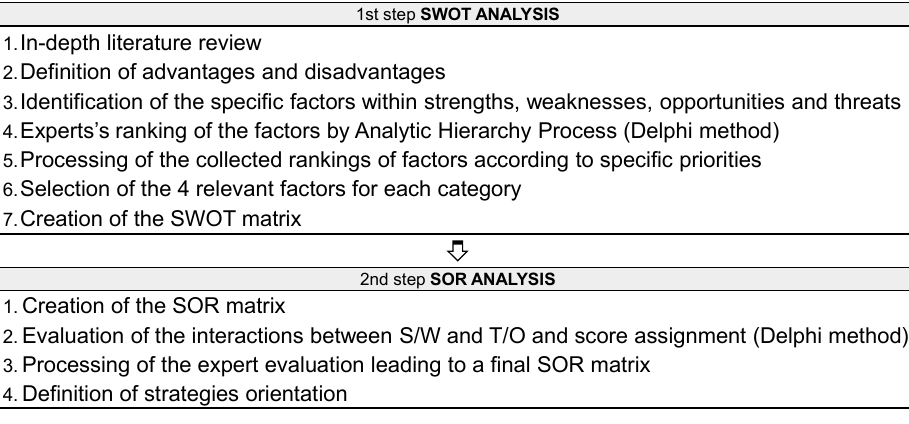
Figure 3. Framework of SWOT-SOR analysis applied to the selected technologies.